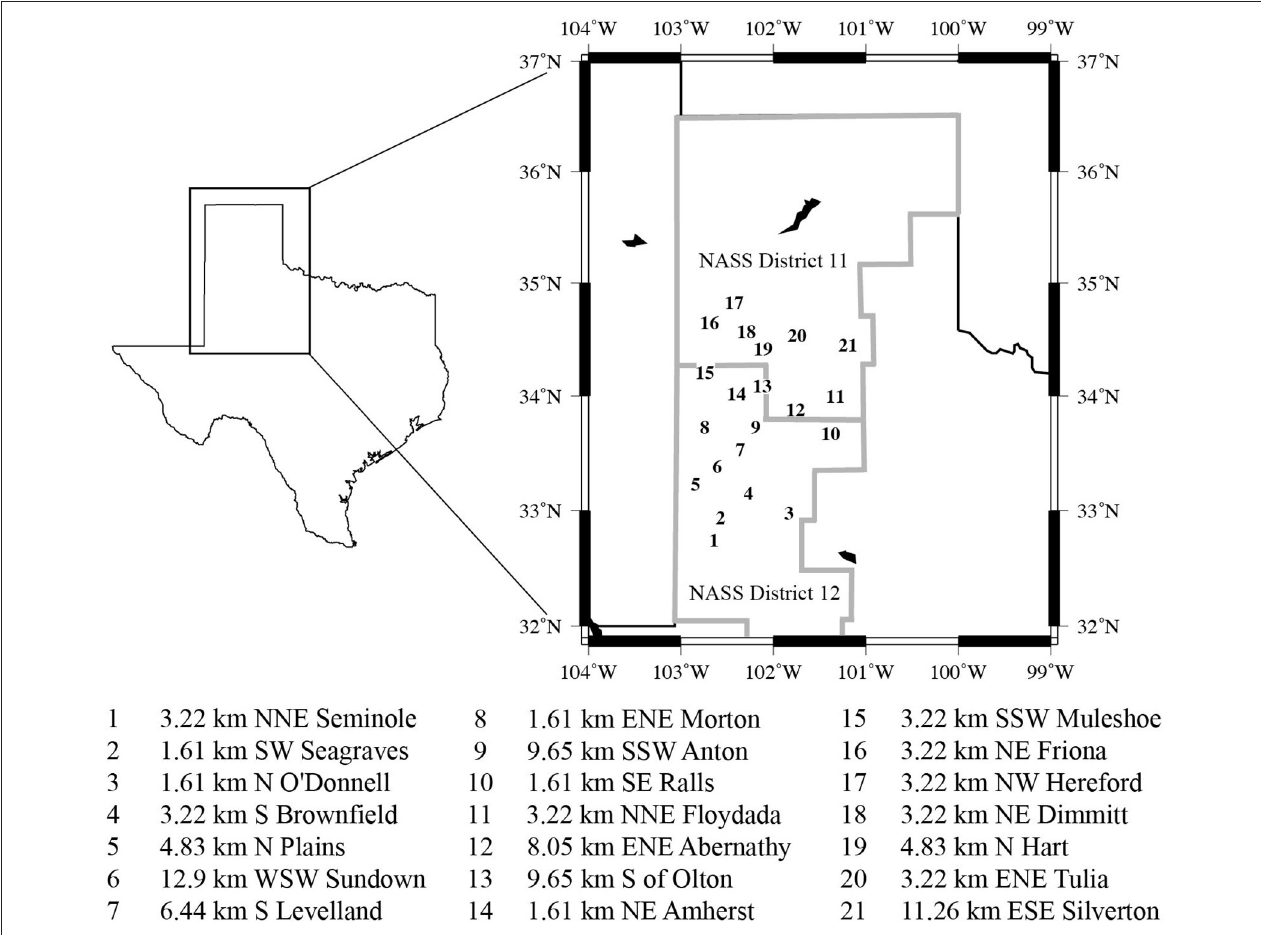
FIGURE 1 | Locations of the 21 mesonet weather stations used to provide weather input data for the CROPGRO-Cotton model during